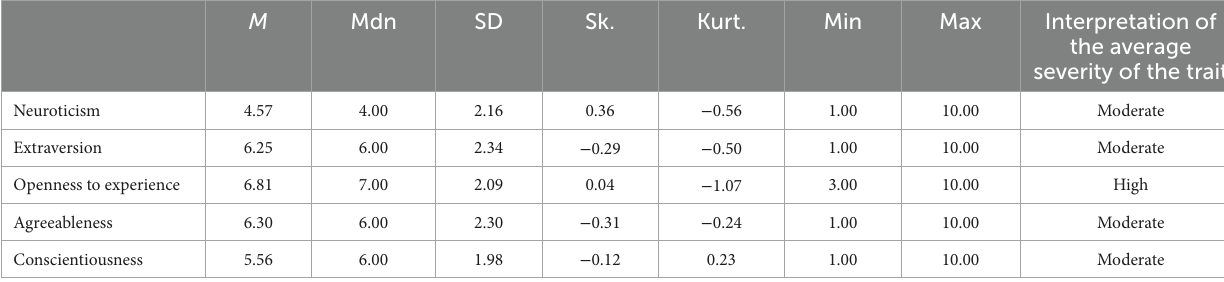
TABLE 1 Basic descriptive statistics for individual personality traits of mountaineers. M Mdn SD Sk.